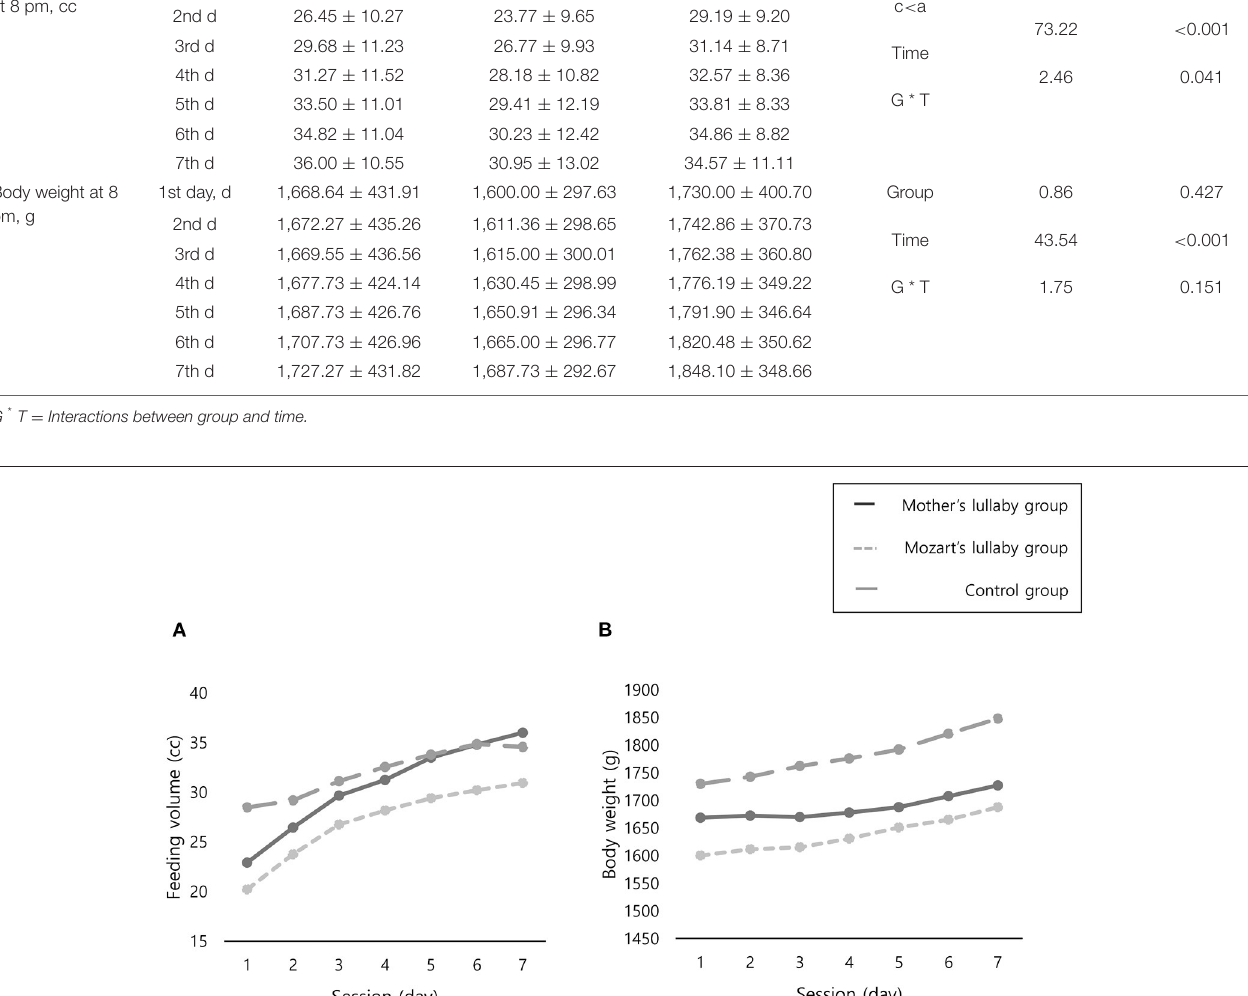
Feeding volume at 8 pm, cc